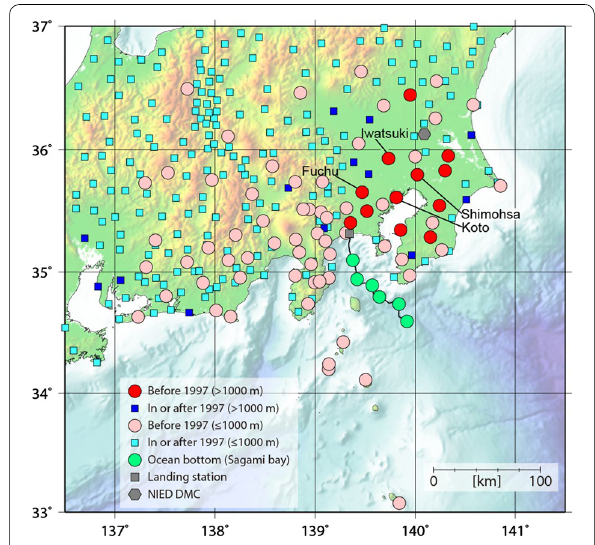
Fig. 2 Hi-net station distribution in and around the Kanto-Tokai area. The circles and squares denote stations constructed before and in or after 1997, respectively. Deep and semi-deep boreholes (> 1000 m) are represented by the red circles and the blue squares, respectively. Stations with seismometers of the ETMC system in the Sagami Bay are shown by the green